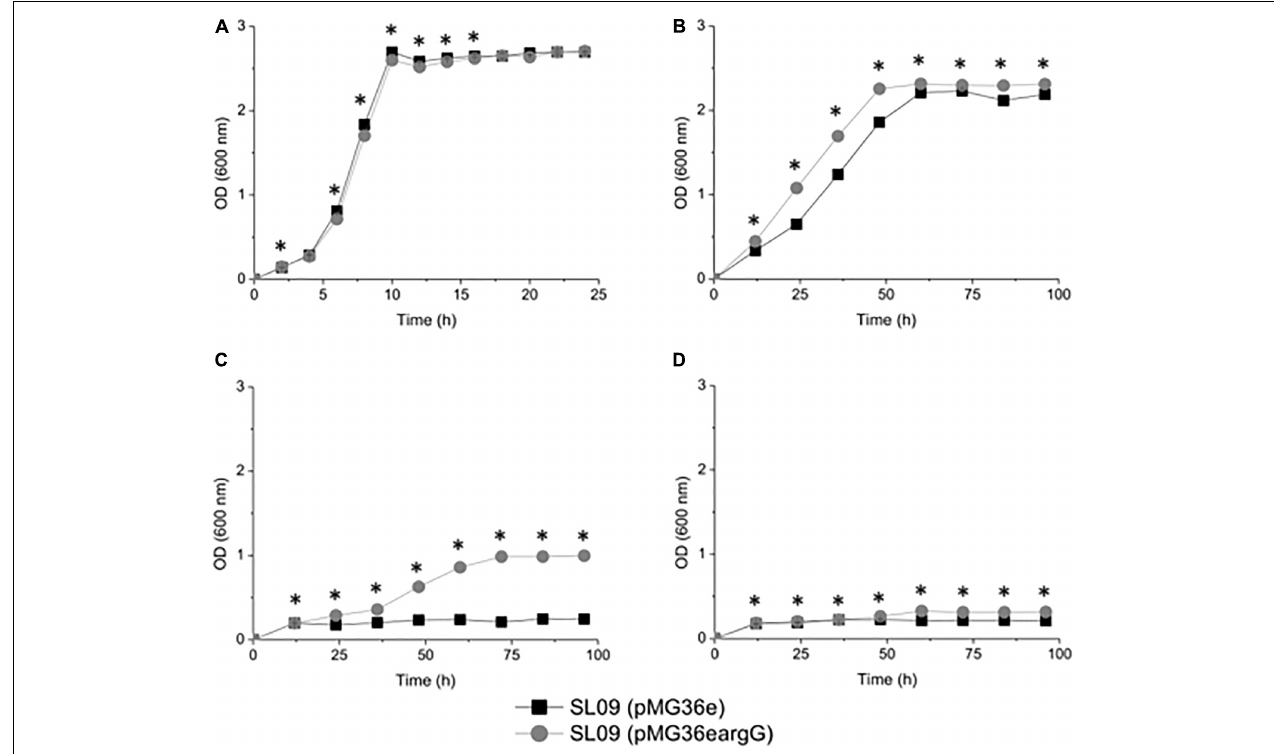
FIGURE 3 | Growth curve of the recombination strain and the control strain under different pH conditions. (A) pH 6.3, (B) pH 3.7, (C) pH 3.3, and (D) pH 3.2. Values presented are the mean of three independent experiments. ∗ Difference significant at 95% confidence